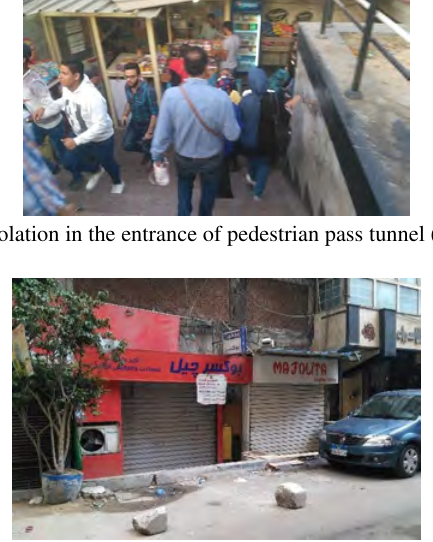
Figure 11. Sidewalks distortions in terms of widths, paving, regularity, and levels (The researcher, 2017)